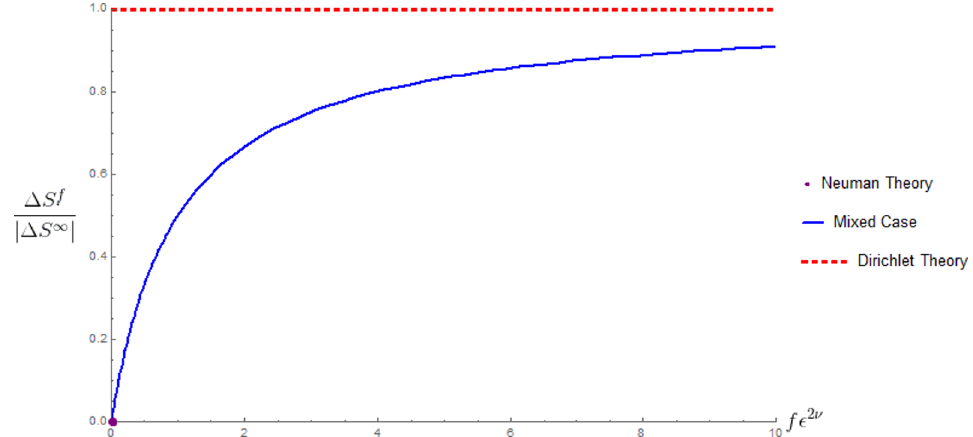
Figure 5 . This plot shows (cid:1) S f increases